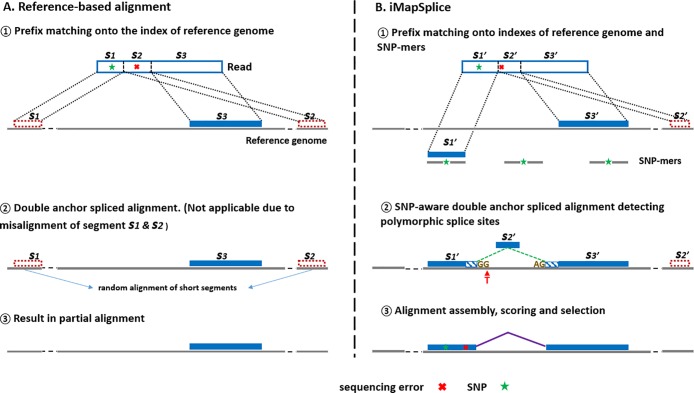
An overview of iMapSplice algorithm.(A) An example illustrating the challenge when mapping a RNA-seq read to the reference genome in the presence of SNPs. (B) An example illustrating how iMapSplice algorithm may resolve spliced alignment with SNPs as well as the basic steps of the alignment.